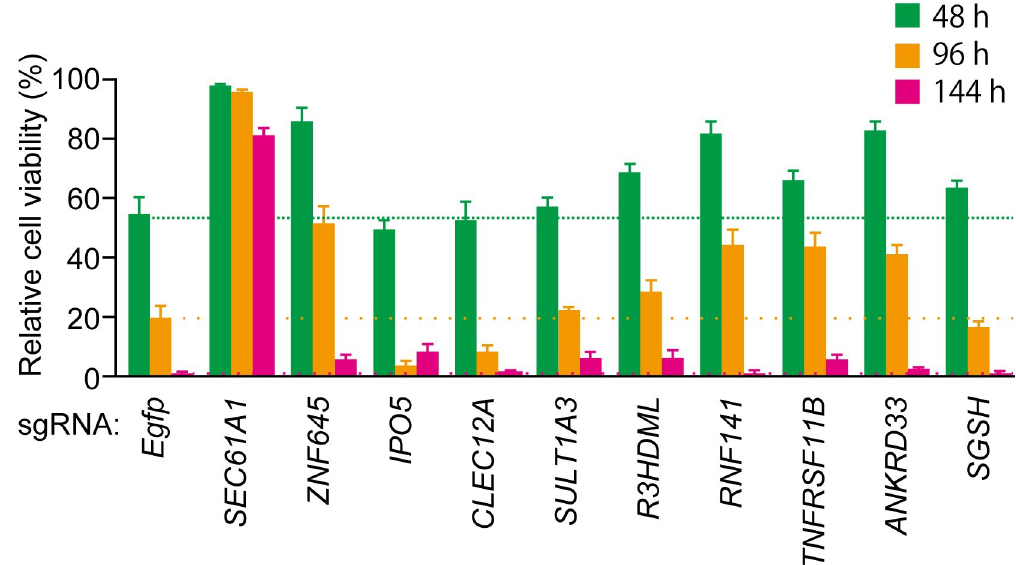
Fig 3. Viability of sgRNA-transduced THP-1 cells treated with mycolactone. The top 10 sgRNAs identified by MAGeCK screening were introduced into THP-1 cells. Then, the cells were treated with mycolactone at 30 ng/mL for 48, 96 and 144 h, after which cell viability was determined by the trypan blue exclusion assay (n = 5). Data are expressed as the cell viability relative to that of non-treated EGFP -knockout cells. � : p < 0.05; �� : p < 0.01; ��� : p < 0.005.